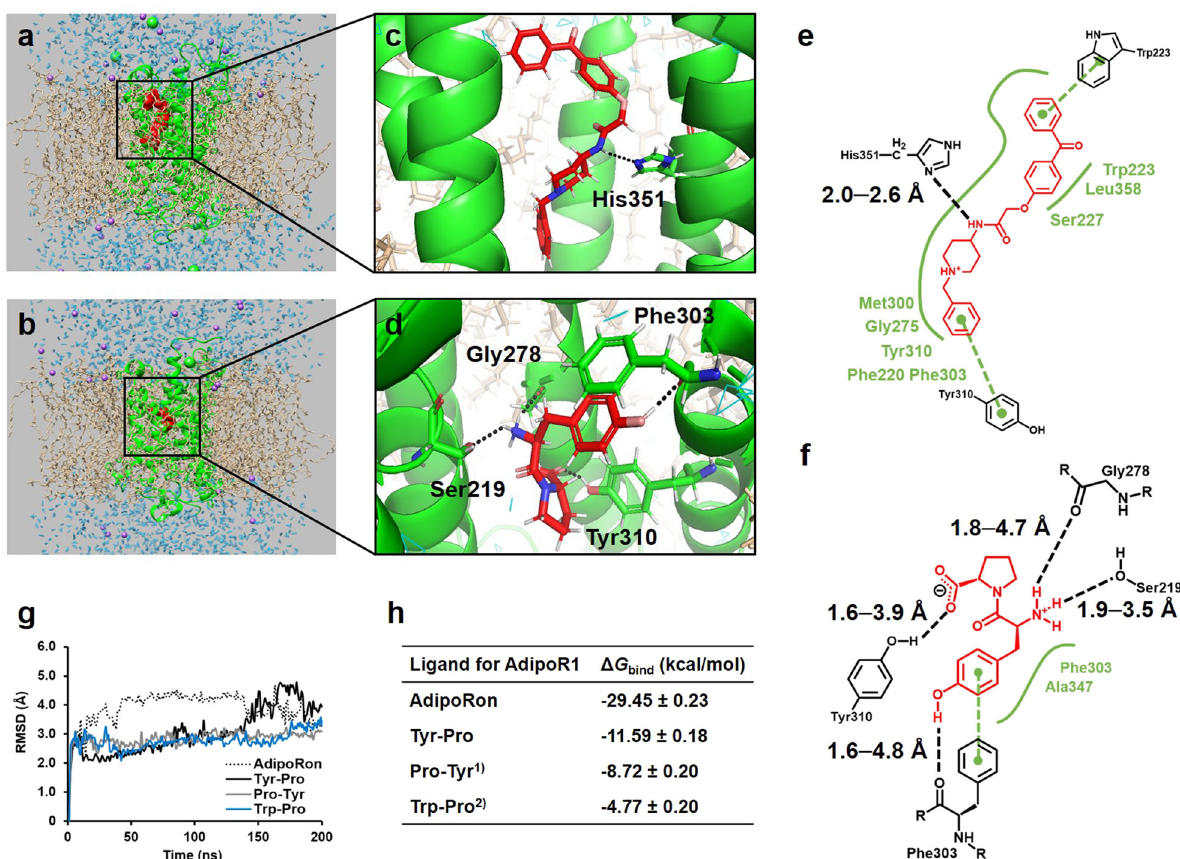
Fig. 5 In silico analyses at site 1. MD simulation analyses of the CHARMM-GUI-guided ( a ) AdipoRon – AdipoR1 – POPC complex and ( b ) the Tyr- Pro – AdipoR1 – POPC complex at site 1 of AdipoR1, visualized using UCSF Chimera ver. 1.14. The corresponding colors are as follows: Na + , green sphere, Cl − , purple sphere; POPC, yellow; water molecule, cyan. The zoomed view snapshot at 200 ns using PyMOL displays the binding conformations of ( c ) AdipoRon and ( d ) Tyr-Pro complexes. The corresponding colors are as follows: C atom, red; H atom, white; N atom, blue; O atom, pink. Intermolecular interactions of ( e ) AdipoRon and ( f ) Tyr-Pro complexes at 200 ns were visualized using Protein Plus . Binding conformations are as follows: hydrogen bond, black dashed line; hydrophobic interaction, green straight line; π – π electron interaction, green dashed line. g A protein backbone root-mean-square deviation (RMSD) value from the initial structure of the ligand – AdipoR1 – POPC complex was computed for 200 ns. h The average binding free energy scores for 180 – 200 ns, Δ G bind (kcal/mol) of AdipoRon – AdipoR1, Tyr-Pro – AdipoR1, Pro-Tyr – AdipoR1, and Trp-Pro – AdipoR1 complexes in POPC. 1) MD simulation analyses for Pro-Tyr at site 1 can be seen in Fig. S7 and Movie S3. 2) MD simulation analyses for Trp-Pro at site 1 can be seen in Fig. S7 and Movie